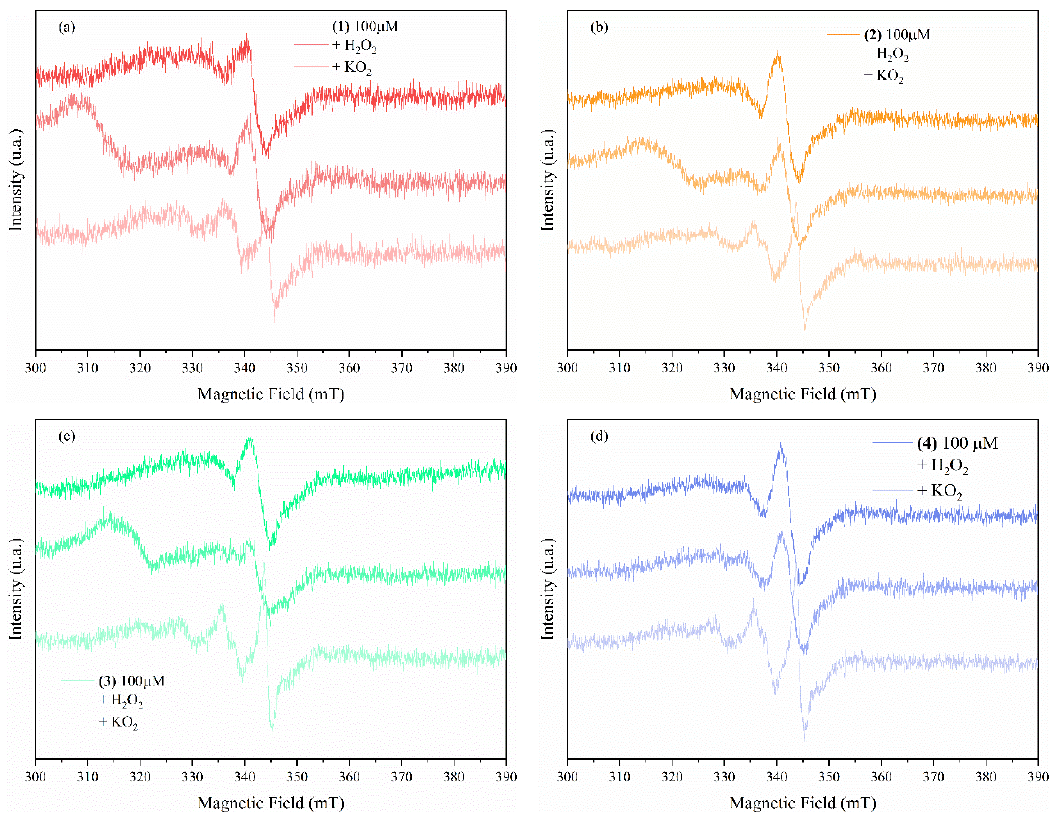
Figure 10. EPR spectra of the complexes (( 1 )-( a ), ( 2 )-( b ), ( 3 )-( c ), and ( 4 )-( d )) in a 100 µM DMSO so- lution and in the presence of KO 2 and H 2 O 2 . solution and in the presence of KO 2 and H 2 O 2